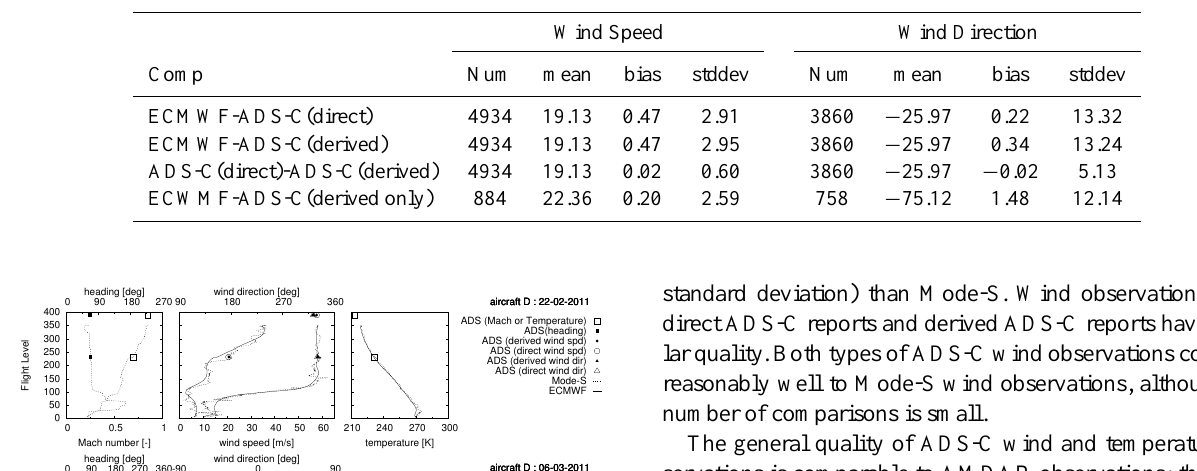
Table 5. Statistics of the comparison of wind (direct and derived) observations from ADS-C versus